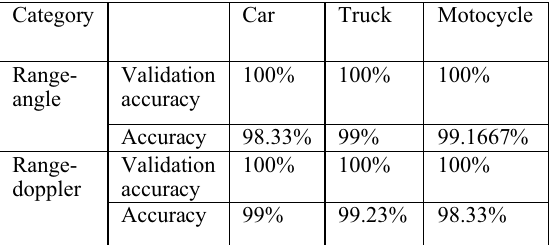
Fig. 12. Range-Speed response with clutter and jammer